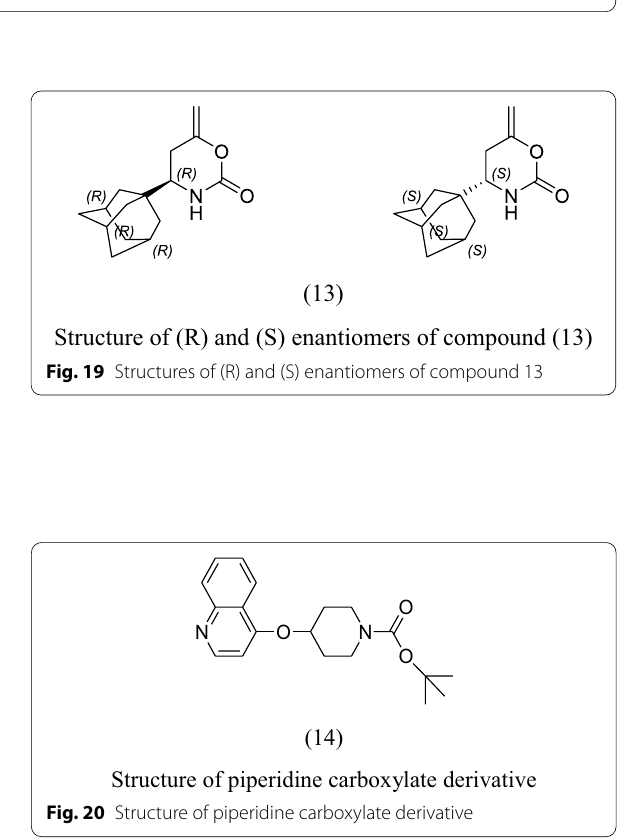
Fig. 18 Structure of 1‑piperidinylimidazole derivatives